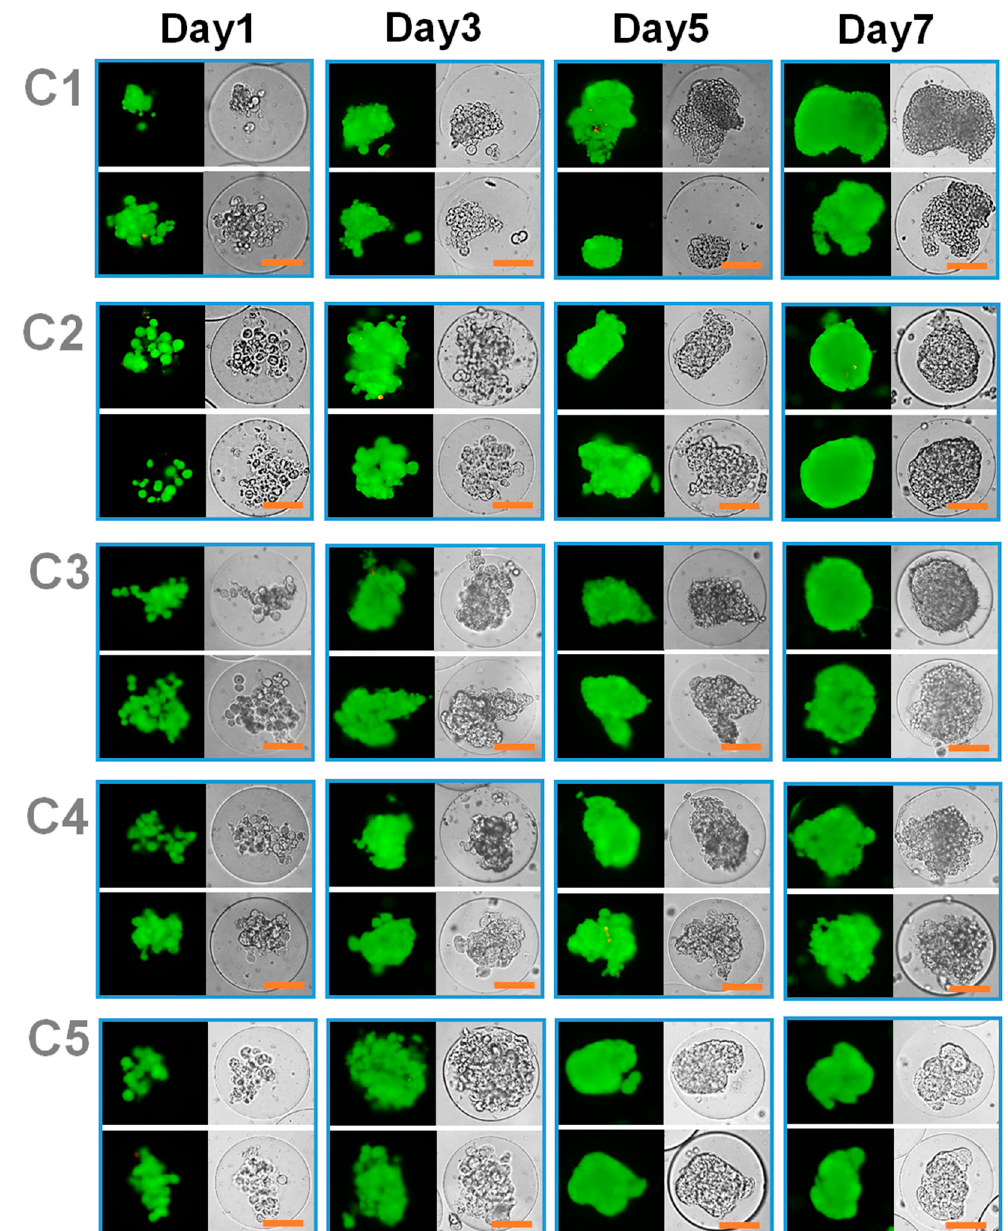
Figure 7. Optical ( left ) and fluorescent ( right ) microscopic images of MCF-7 cells and macrophages (5:5 ratio) co-encapsulated in the microgels with various mechanical stiffness (from C1 to C5) (scale bar: 50 um). The cells were fluorescently labeled to visualize live (green) and dead (red) cells.